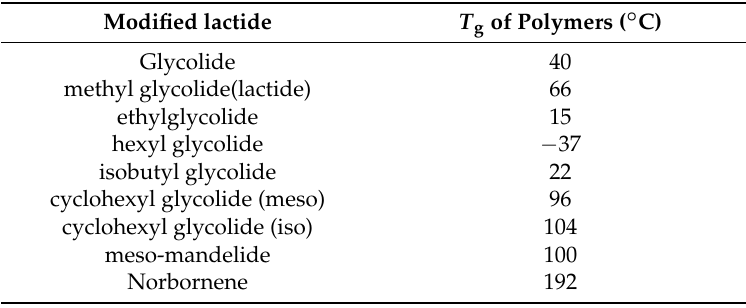
Figure 10. ( a ) Phenyl-substituted PLA; and ( b ) high- T g polymer produced from norbornene-substituted lactide. Table 8. Chemical structure of modified lactides and their T g values